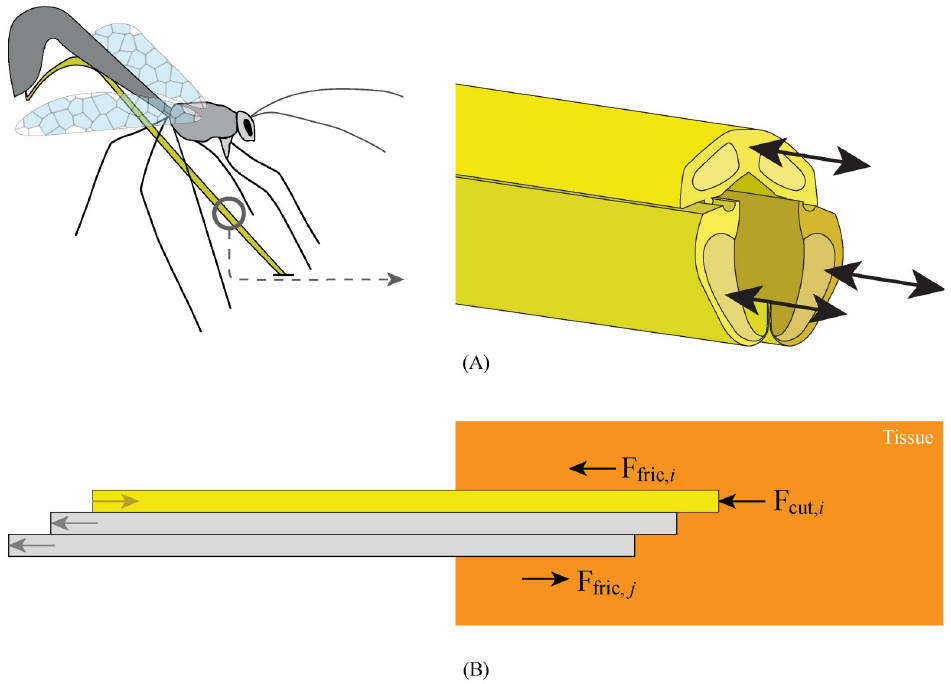
Fig 1. Visualisation of the motion sequence of the ovipositor of a parasitic wasp. (A) The ovipositor consists of three parallel valves that can move reciprocally (based on Cerkvenik et al . [20]). (B) Schematic illustration of ovipositor-inspired needle insertion into tissue with one advancing needle segment (yellow) and two retracting needle segments (grey). F fric, is the friction force along the advancing needle segment, F cut, is the cutting force on the tip of i i the advancing needle segment, and F fric, j is the friction of the retracting needle segments, which works in the opposite direction as the friction force of the advancing needle